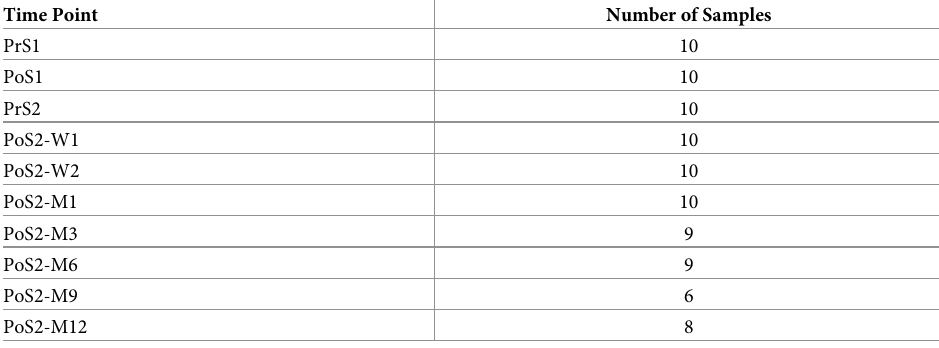
Table 2. Total number of patient samples collected at the pre-selected time points.